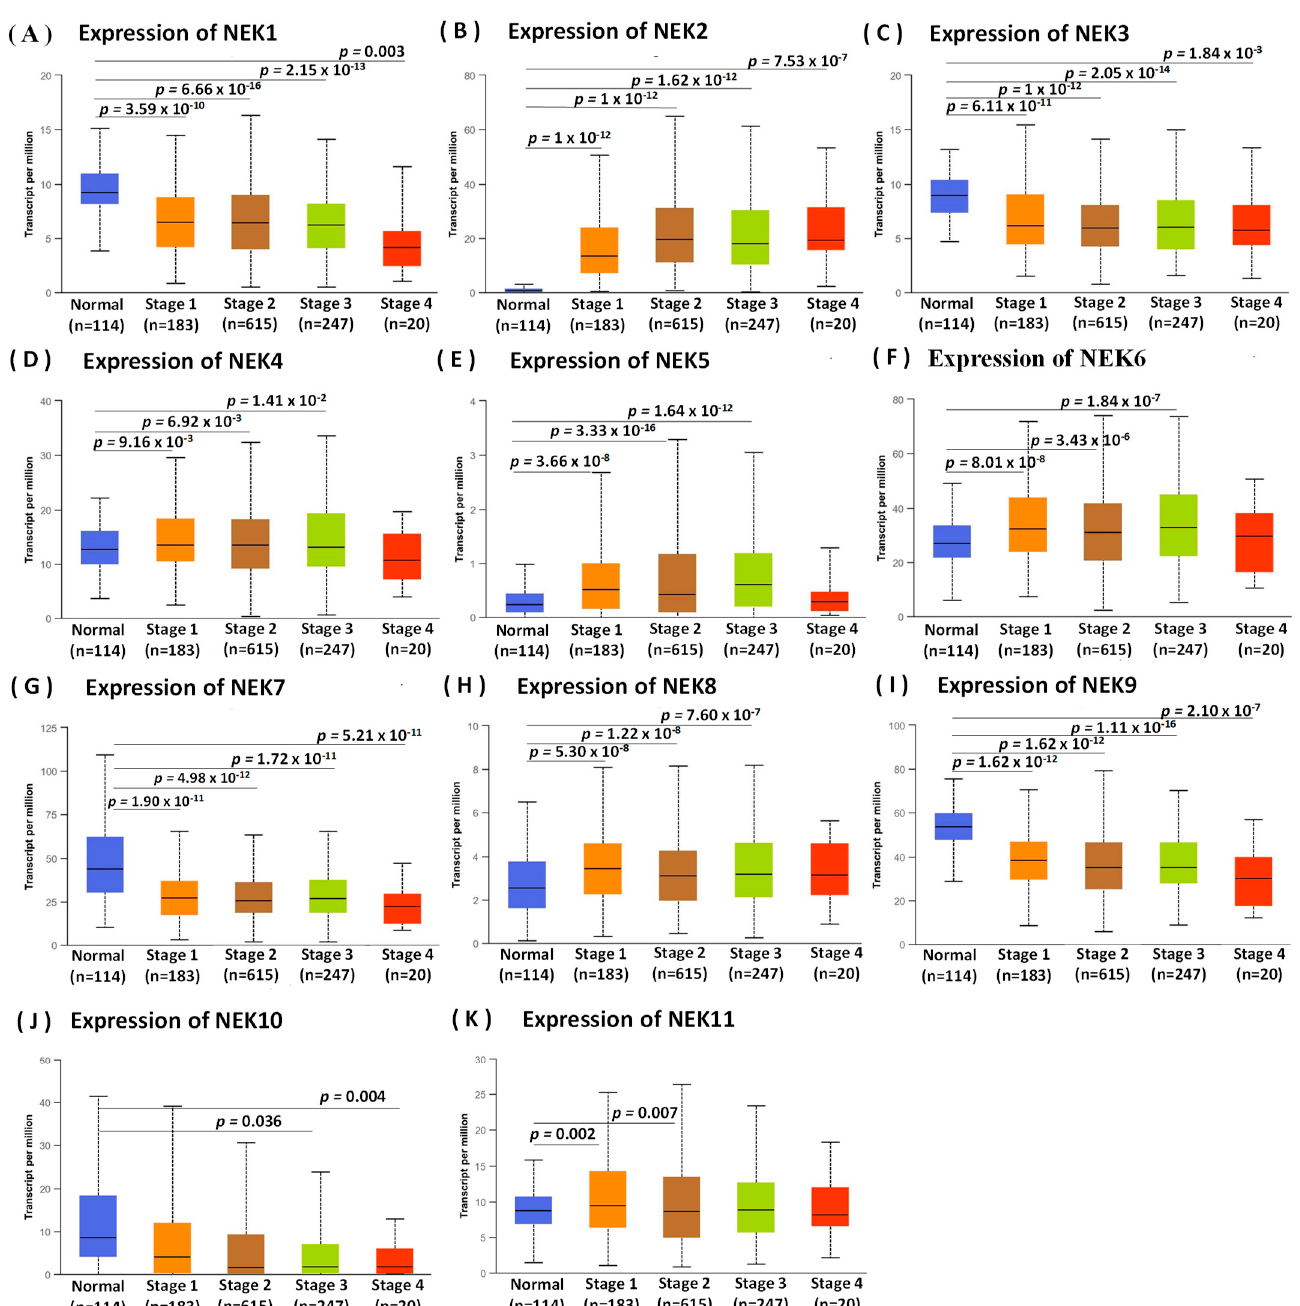
Figure 4. Expression transcript levels of the NEK gene family in normal tissues with individual cancer stages or clinico- pathology (UALCAN analysis). ( A – K ) Box plots of the NEK gene family transcripts in normal tissues and various tumor stages (breast cancer, BRCA). An independent t -test was used to calculate p values. Statistical significance was indicated by p < 0.05.